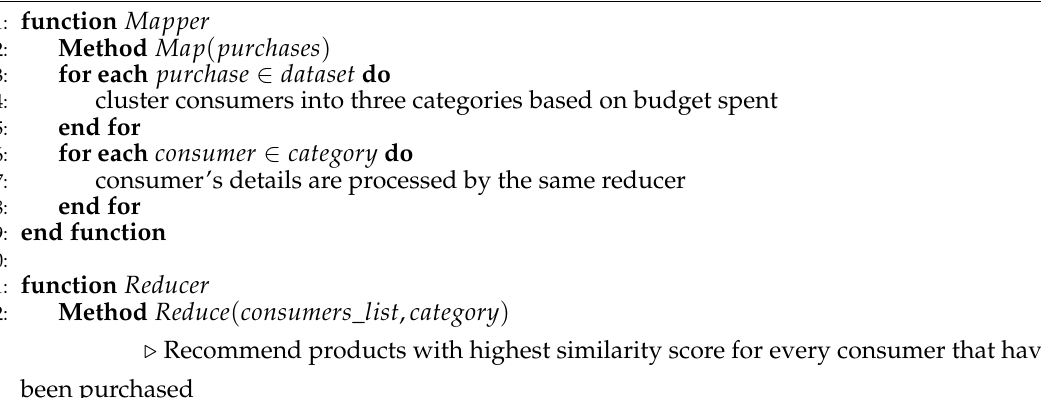
Algorithm 5 Distributed